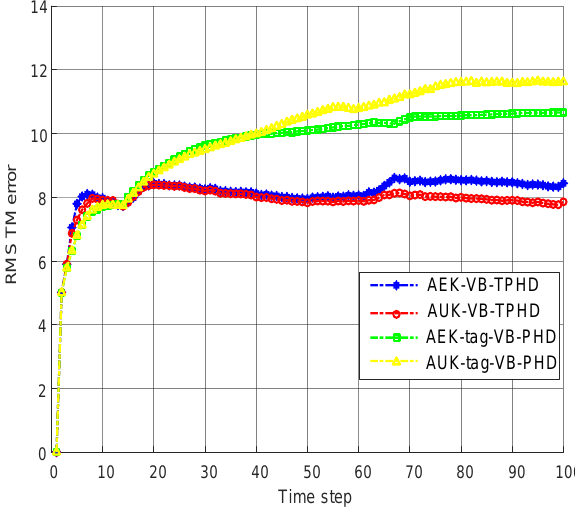
Figure 8. Comparison of VB-TPHD and tag-VB-PHD using EK and UK nonlinear realization forms